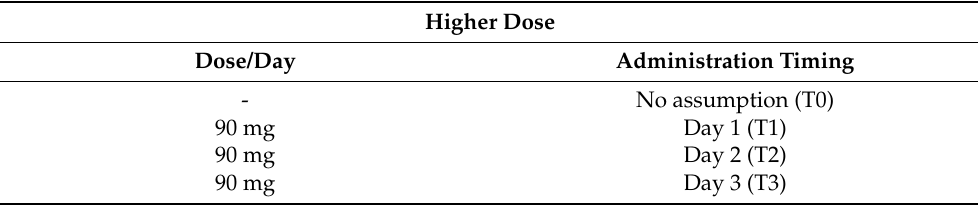
Table 7. Doses and timing of sulforaphane (SFN) administrations in both volunteers enrolled (HV1, HV2). The second-round dose treatments were considered high doses and referred as “higher